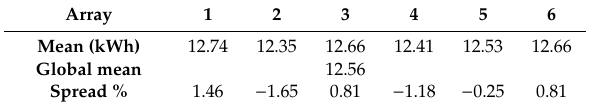
Figure 7. ( a ) Energy produced by array #1 in nine months and its mean value as red line; ( b ) upper and lower BB 20 of array #1 in red color, and EMA 20 in magenta color. ( c ) and ( d ) refer to array #2. ( e ) and ( f ) refer to array #3. Table 3. Mean energy and spread with respect to the global mean for the nine-month